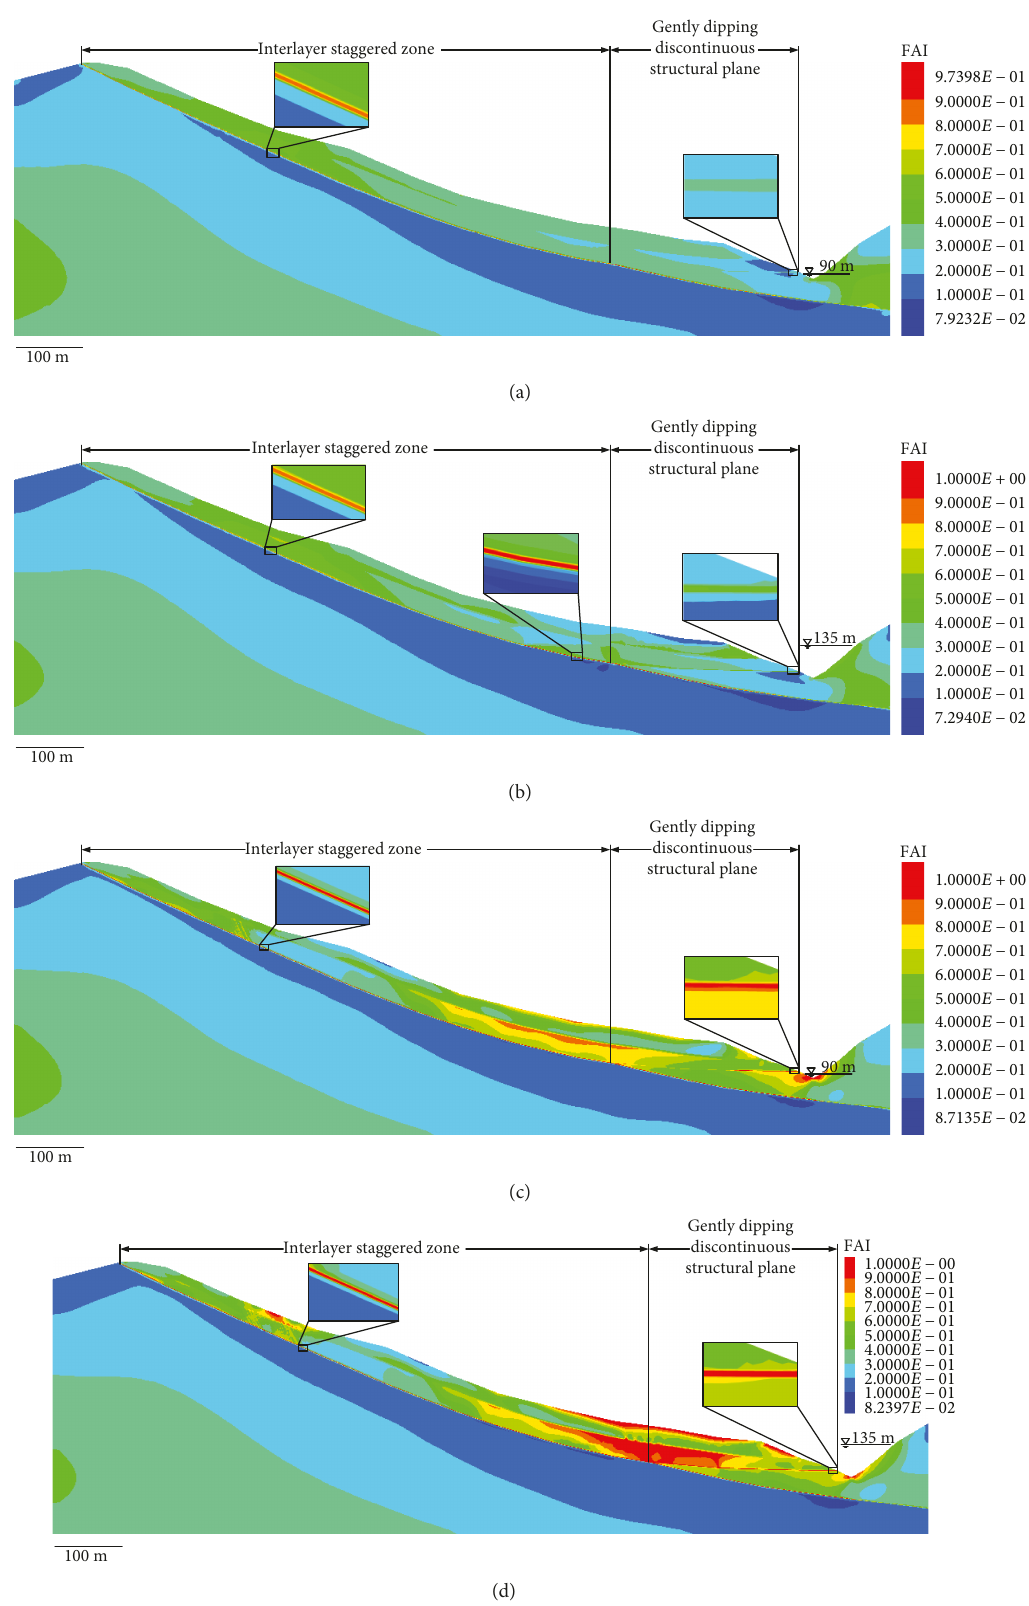
Figure 8: The FAI distributions of each